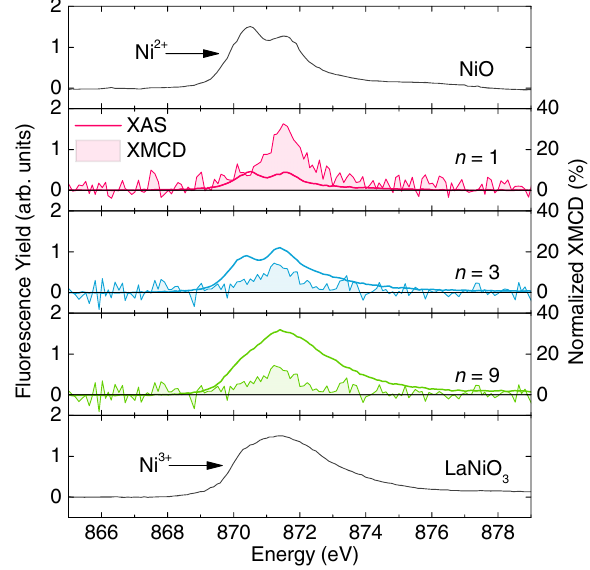
FIG. 2. Interfacial charge transfer and magnetic dichroism. X-ray absorption spectroscopy at the Ni L 2 edge for ð LaNiO 3 Þ ð La Þ 2 = 3 Sr 1 = 3 MnO 3 9 superlattices (thick lines) showing progres- sion from Ni 3 þ to Ni 2 þ as n is varied from 9 to 1. The shaded regions show the x-ray magnetic dichroism over the same energy range, confirming the existence of magnetism on the Ni